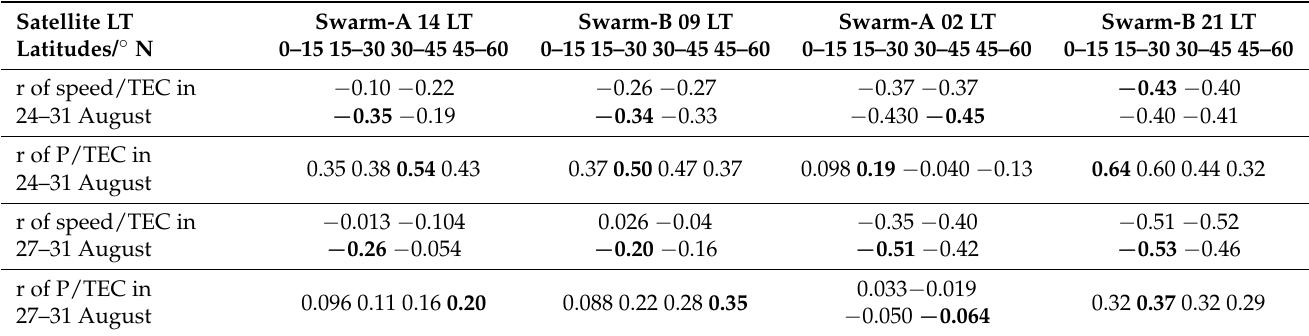
Table 3. The correlation between TEC from Swarm satellites and solar wind speed and pressure. The bold values present the